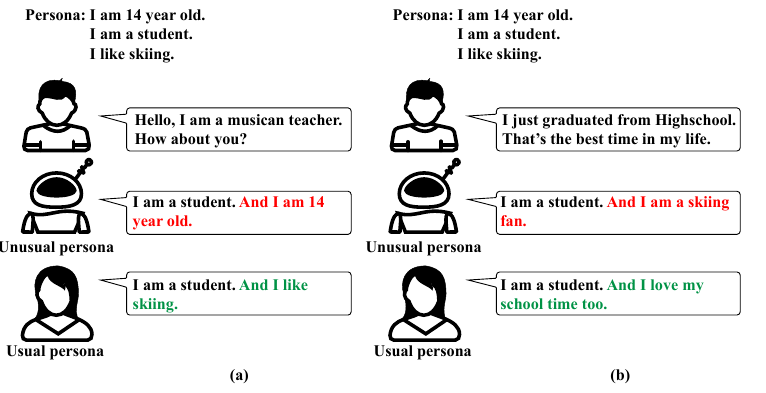
Figure 2. Examples of conversation using different persona. ( a ) Humans usually do not show private information in the beginning. ( b ) To show persona, agent selects the persona “I like skiing”, although it would be better not to select the other given